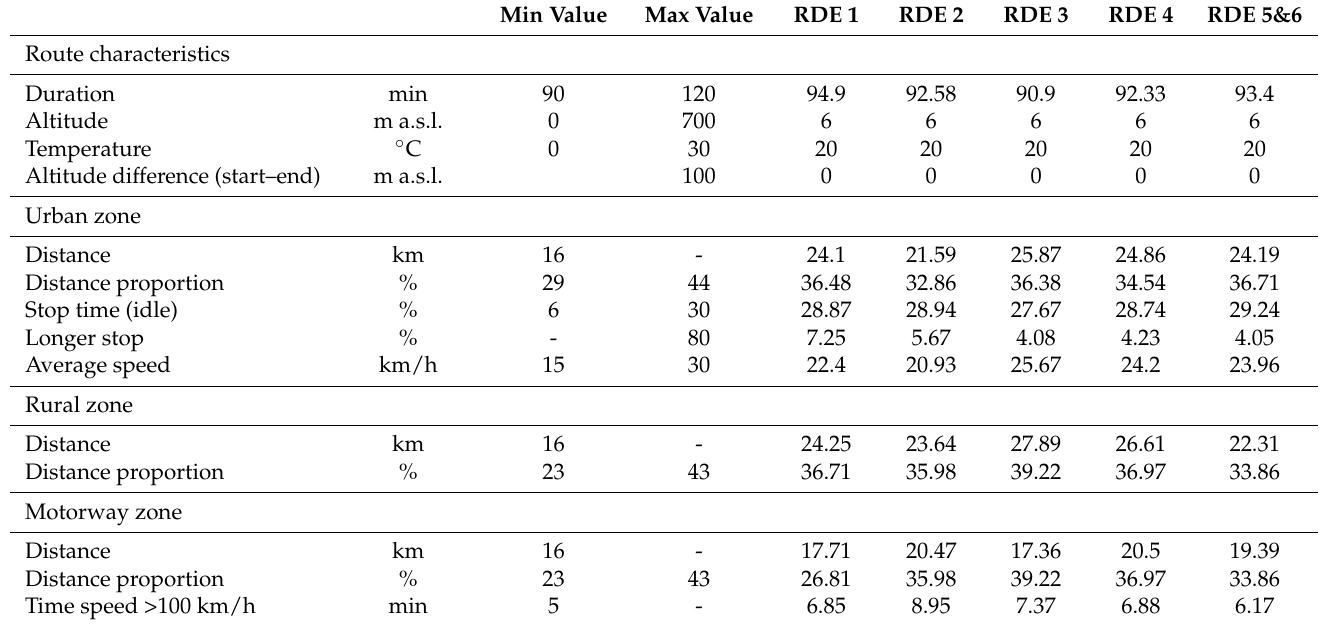
Table 4. RDE cycles